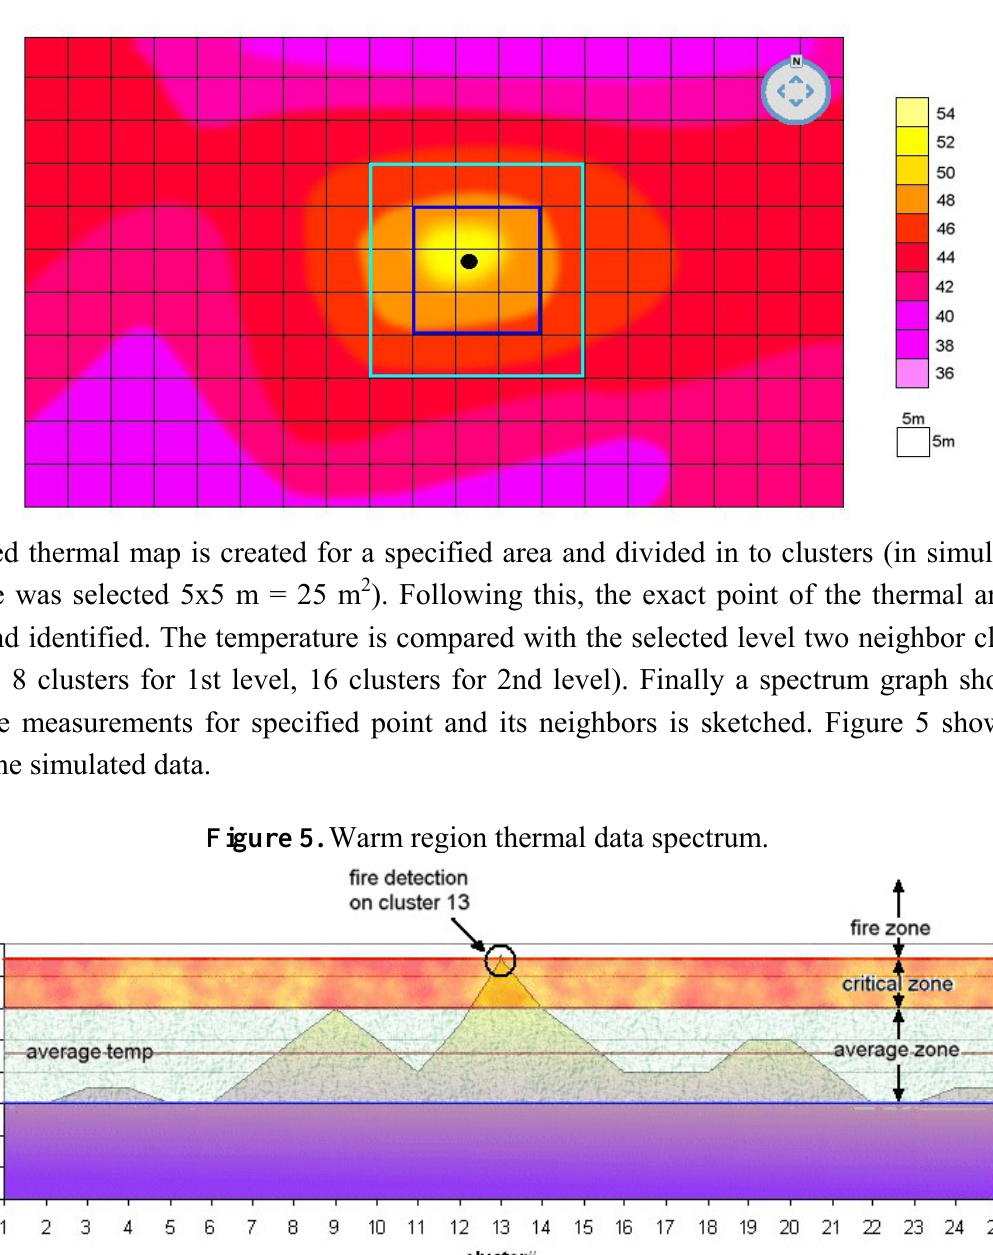
Figure 4. Refined thermal map of a warm region.